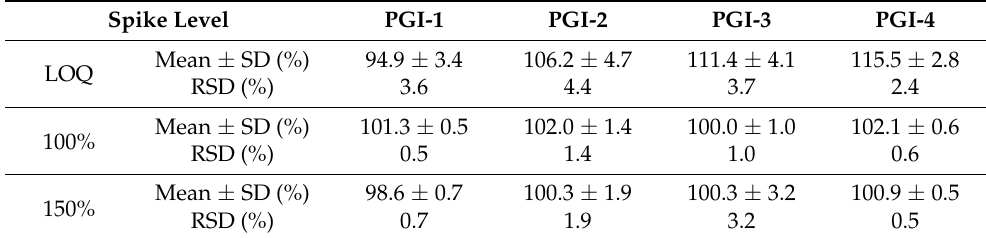
Table 2. Summary of accuracy results ( n = 3).